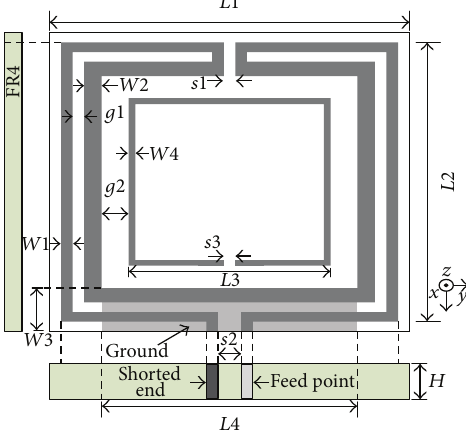
Figure 2: Geometry of the proposed antenna.